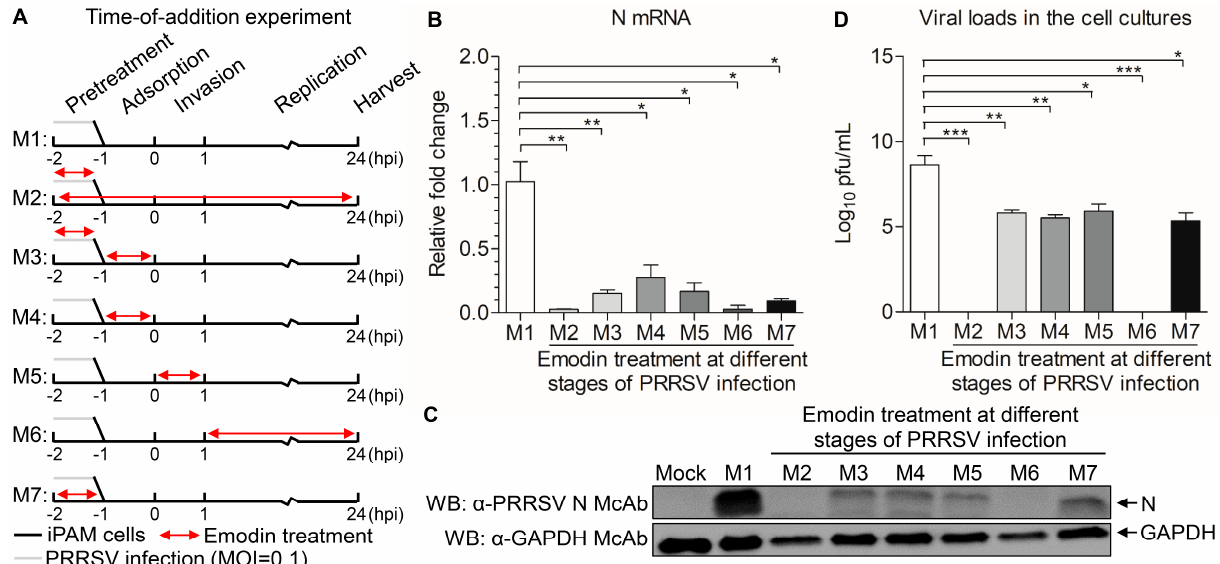
Figure 4. Effect of Emodin treatment on the replication stages of PRRSV. ( A ) iPAMs infected PRRSV were treated with Emodin (6.25 μ g/mL) or 0.1% DMSO at different stages (M1-M7) of infection. Cells were harvested at 24 hpi, then the viral yields were titrated by ( B ) real-time PCR using specific primers, ( C ) Western Blot using anti-PRRSV N monoclonal antibody and anti-GAPDH monoclonal antibody and ( D ) TCID 50 assay. The results are representative of three independent experiments (mean ± SD). n = 3. * p < 0.05, ** p < 0.01, *** p < 0.001.